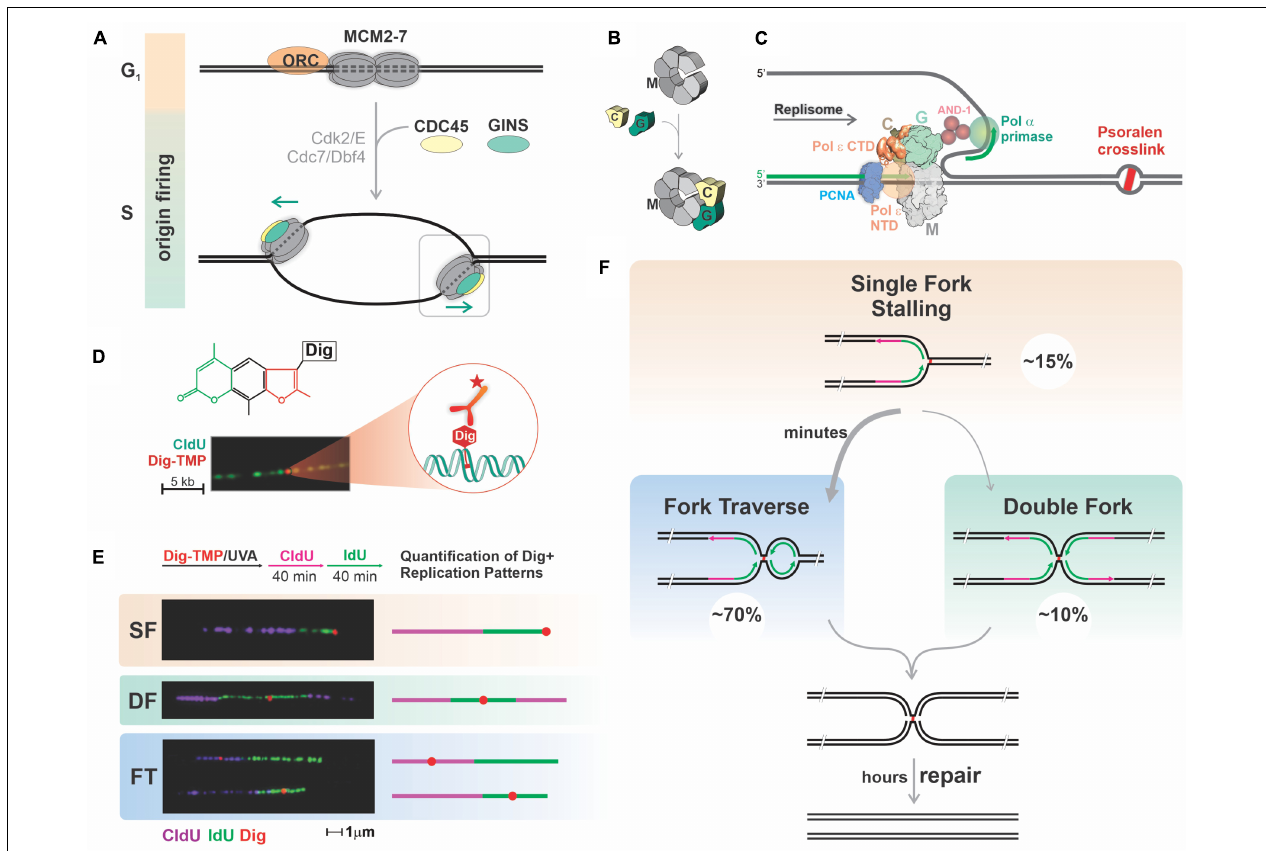
FIGURE 1 | Mammalian replication forks faced with potent blocks restart DNA synthesis past the block, prioritizing replication over repair. (A,B) Several mechanisms ensure proper regulation of replication origin firing to prevent re-replication of chromosomal DNA. Origin licensing, the process of loading double hexamers of MCM2-7 (M) rings onto dsDNA at many potential origins, occurs exclusively in G1 phase under conditions that prevent initiation. Upon transition into S phase, some of these pre-replicative complexes are activated by association with CDC45 (C) and GINS (G) accompanied by melting of duplex DNA and locking of the MCM ring around the leading strand template. The temporal uncoupling of origin licensing and origin firing restricts replication to once per cell cycle. (C) DNA lesions covalently linking the two DNA strands pose a block to the CMG helicase pulling through the leading strand template. The replisome includes several proteins interacting with the CMG helicase, such as DNA Polymerases α , δ and ε (Pol ε Carboxy and N terminal domains are depicted), PCNA and CTF4. (D) Tagging of TMP with Digoxigenin (Dig-TMP) permits detection of a single ICL on a DNA fiber with Quantum-dot conjugated antibodies against the digoxigenin tag. (E,F) Quantification of replication patterns in the vicinity of ICLs: cells are treated with Dig-TMP/UVA and labeled with pulses of CldU and IdU, followed by DNA spreading, immunostaining, imaging, and quantification. Representative images and schemes of the replication patterns observed and their corresponding percentage. SF, single fork stalling; DF, converging double forks; FT, fork traverse. About 70% of the patterns correspond to fork traverse, which takes 5–6 min to complete. Fork traverse and double fork conversion would result in the same structure. Unhooking of the population of ICLs takes